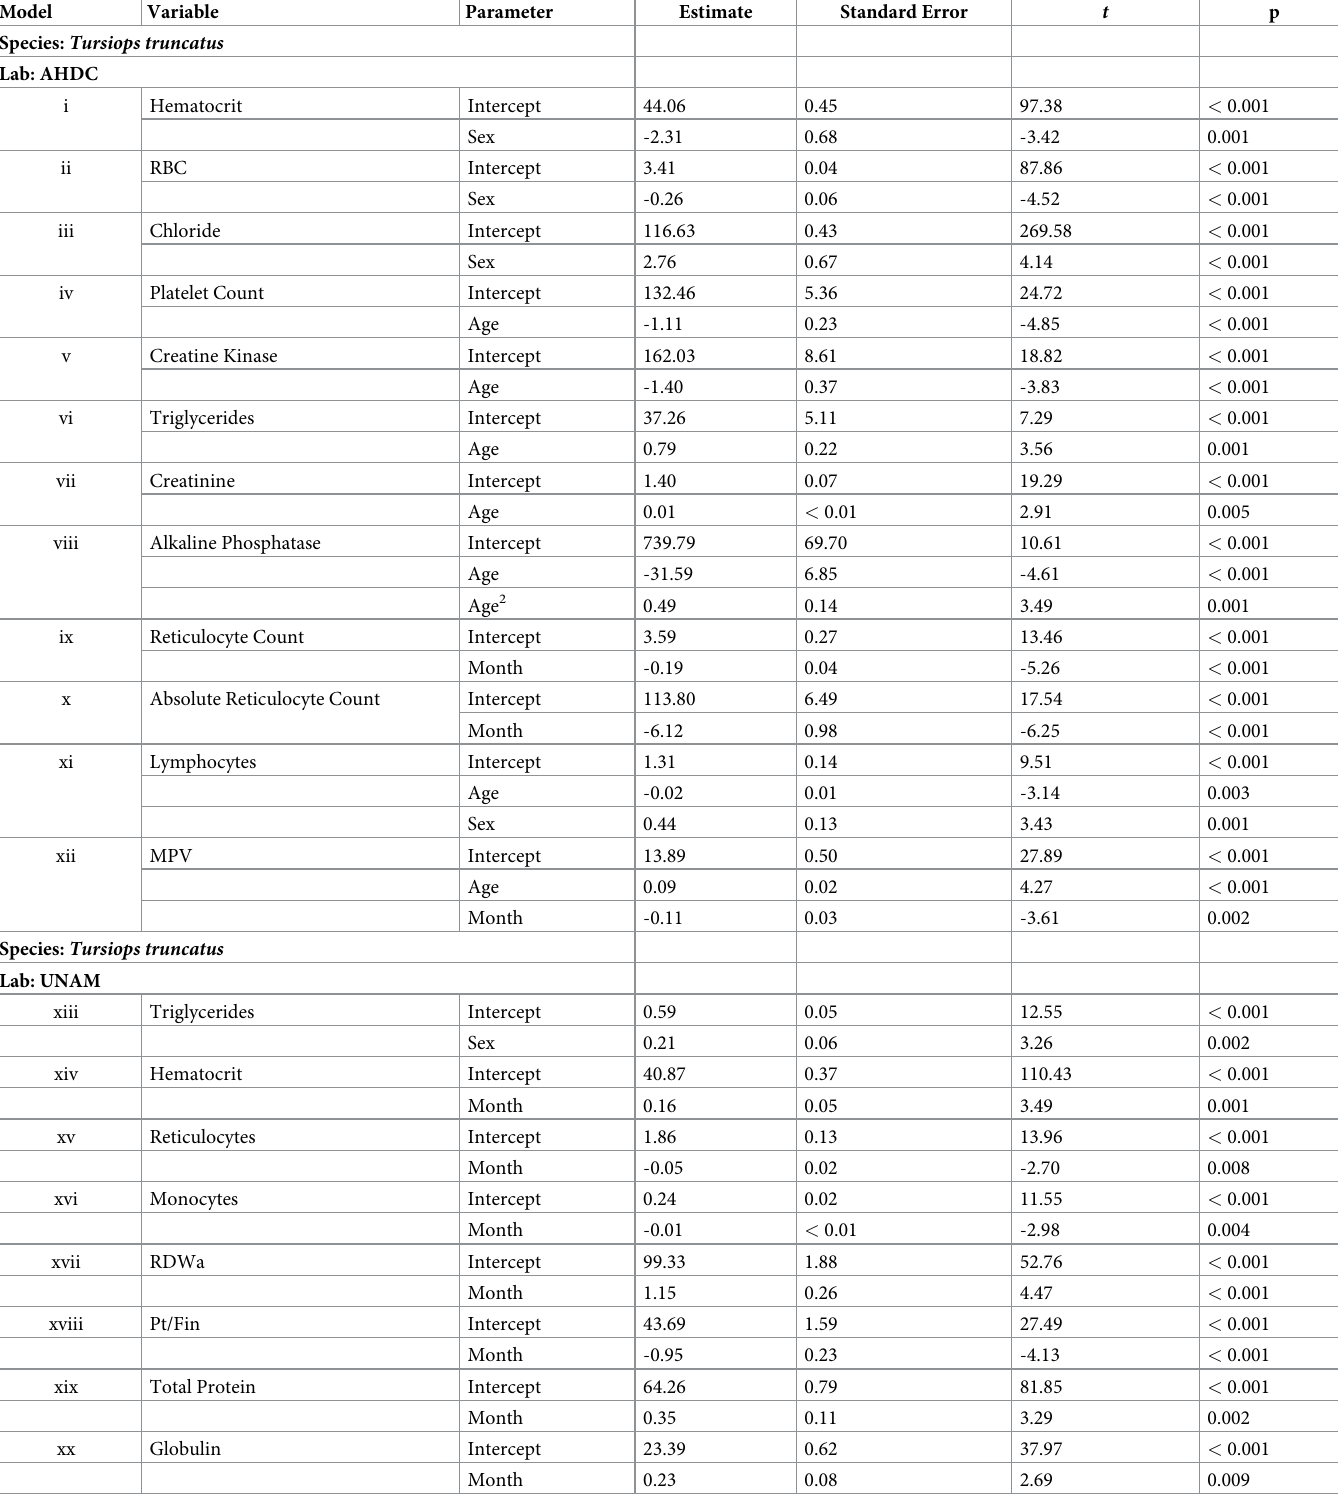
Table 2. Model estimates for predicting blood values.